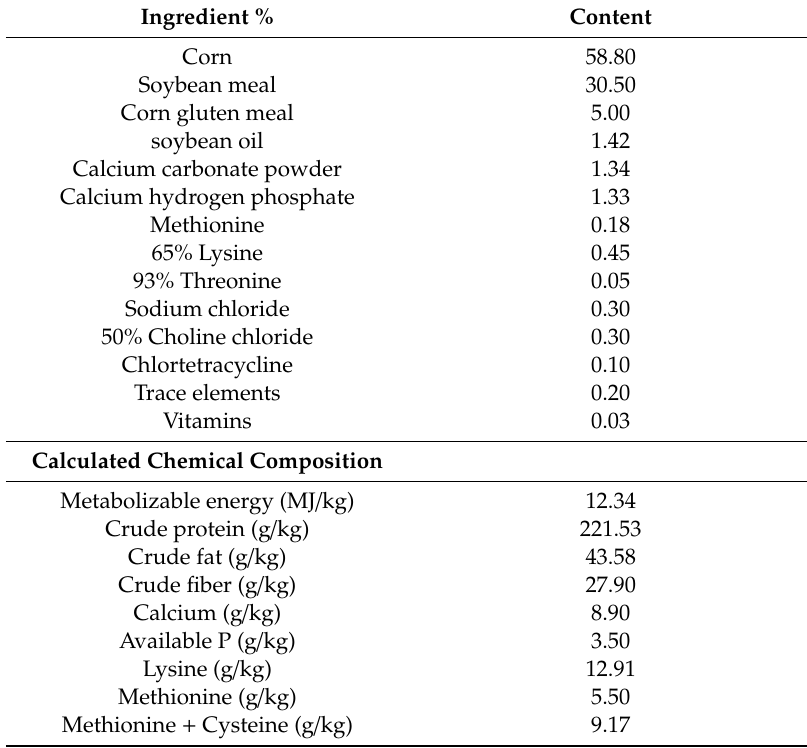
Table 1. The composition of a chicken’s